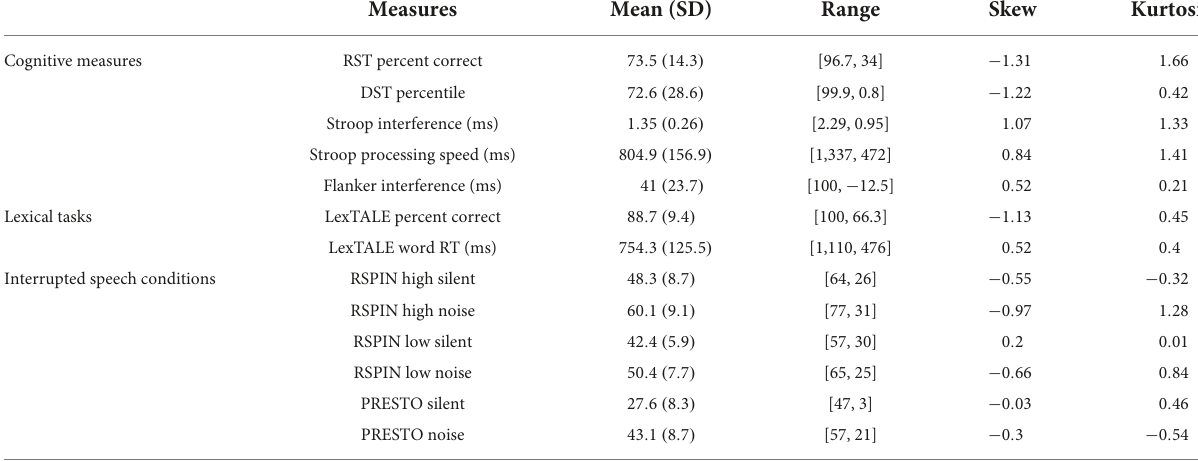
TABLE 2 Descriptive data for experimental tasks.